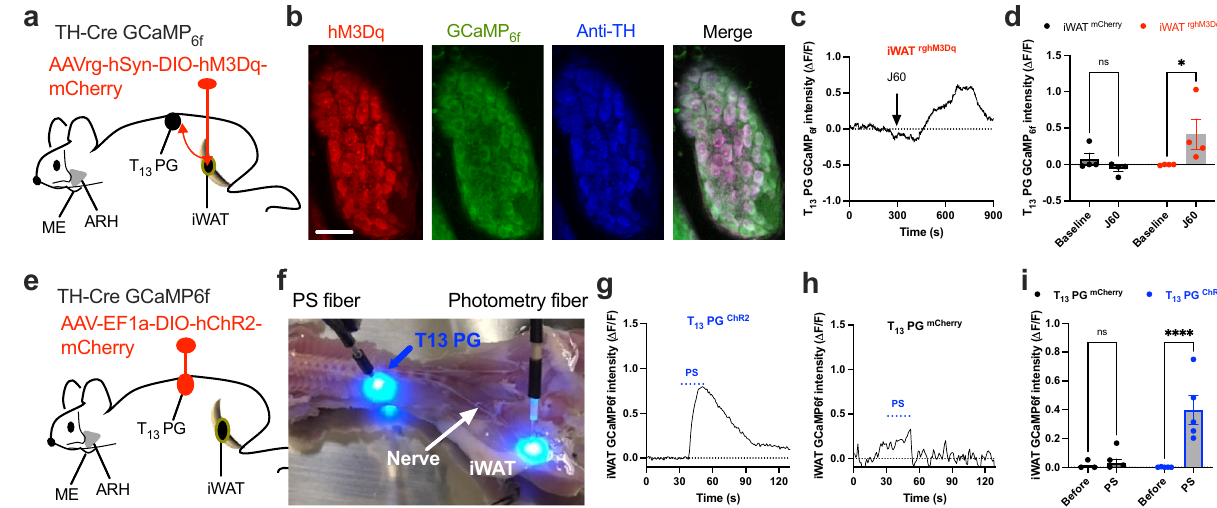
Fig.4 |FunctionalevidenceofT 13 PGprovidingsympatheticinputstoinguinal iWAT. a Schematic illustration of targeting a retrograde vector carrying Cre- dependent hM3Dq-mCherry to inguinal iWAT in dual TH-Cre GCaMP 6f mice. b Sample images showing colocalizations of retrograde traced and hM3Dq- mCherry(red)-transducedTHneuronsstainedwithAlexFluor350-conjugatedanti- TH antibodies (blue) which also expressed GCaMP 6f (green) in T 13 PG. c , d Ex vivo photometry monitoring was performed at acute isolated T 13 PG from the retro- grade traced and hM3Dq-transduced TH-Cre GCaMP 6f mice, and chemogenetic stimulation of the hM3Dq-transduced TH neurons with J60 addition to the circu- lating aCSF increased the intensity of GCaMP 6f signals in the T 13 PG: c A repre- sentativetraceofreal-timemonitoring ofT 13 PGGCaMP 6f signalswithJ60addition as pointed; and d Group data of T 13 PG GCaMP 6f signals in iWAT injected with hM3Dq-ormCherry( n =4pergroup). e – i PSofChR2-transducedT 13